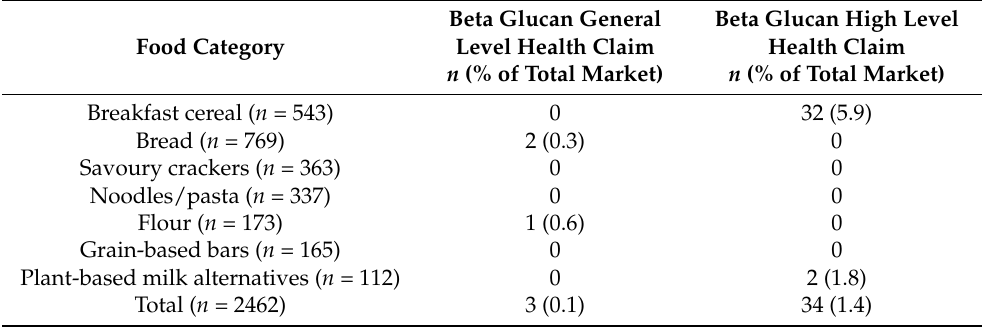
Table 3. Frequency of beta glucan general and high level health claims on products from seven food and beverage categories in Australia.